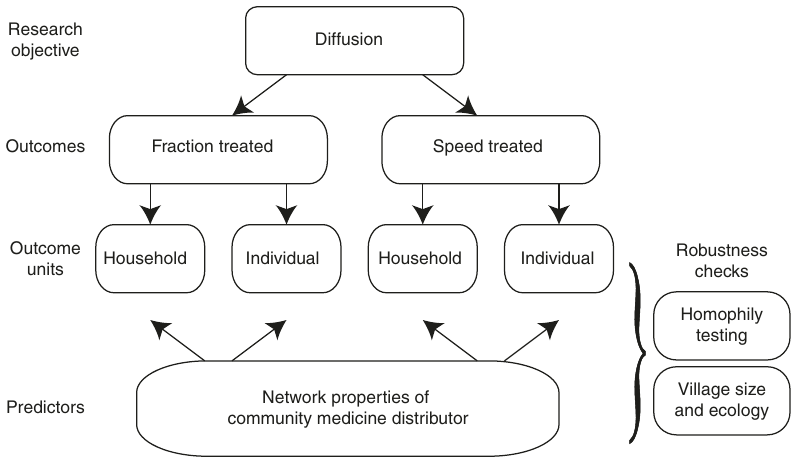
Fig. 5 Schematic of the statistical analysis. The main outcome of interest was diffusion. This outcome was measured as the maximum fraction of eligible households or individuals offered treatment by community medicine distributors (CMDs) and the speed at which those households or individuals were offered treatment. Speed measured which villages reached a speci fi c level of treatment coverage and at which day in the distribution period. The network characteristics of CMDs were the main predictors of interest. To understand why certain network indicators of CMDs may be associated with the diffusion outcomes, robustness checks were conducted. The contribution of homophily to diffusion was assessed, i.e., the af fi nity for treatment or shared factors that may predict treatment coverage and are unrelated to network topology. The robustness checks also included examining village ecology, size, and physical spread of households (in meters) against